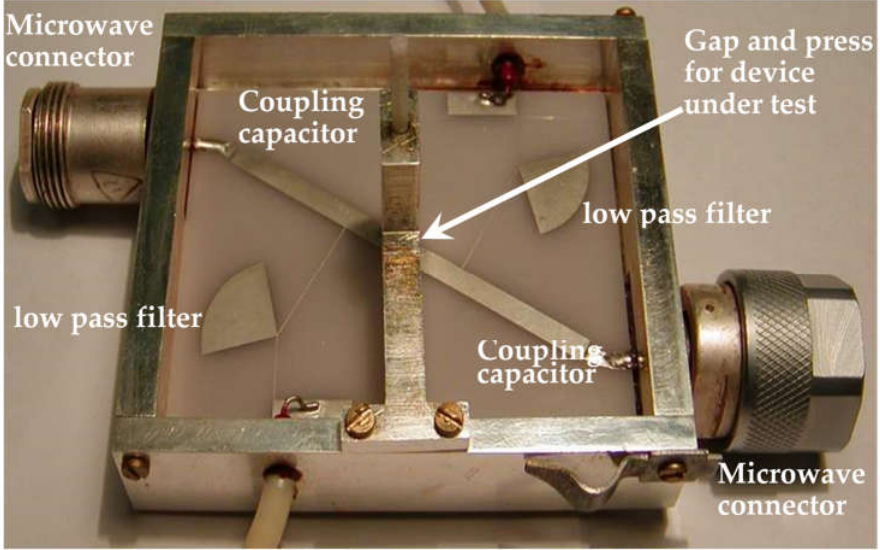
Figure 2. Half-wavelength microstrip resonator for microwave losses